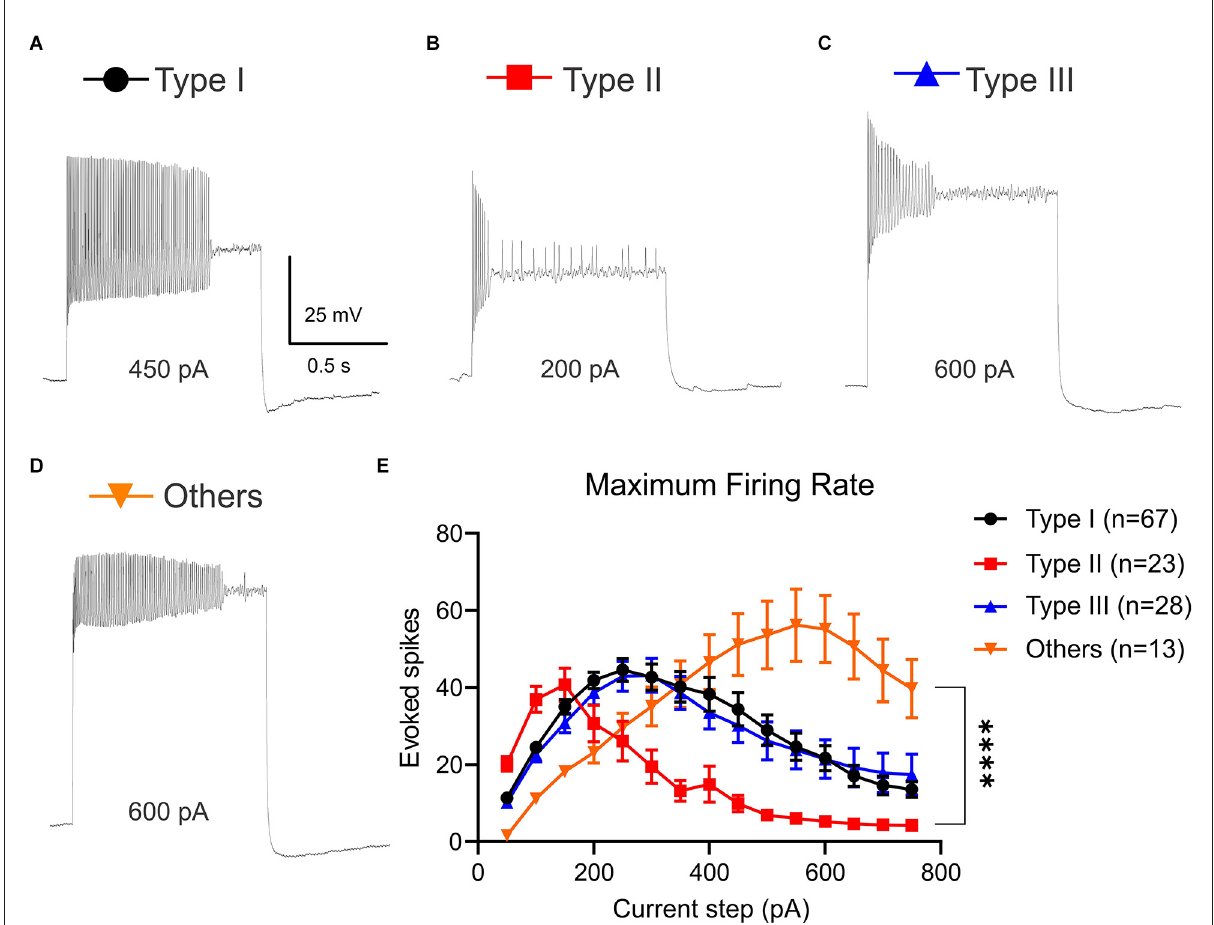
FIGURE3 Maximum firing rate (MFR) of VTA projecting BNST neurons. Current was injected from 50 pA to 750 pA for 1,000 ms. (A–D) Sample traces of each neuron type at current step that exhibits MFR (Type I, 450 pA; Type II, 200 pA, Type III, 600 pA, and Type “Others”, 600 pA). (E) Type II neurons reached depolarization block faster than Type I, Type III, and Type “Others”. A two-way ANOVA revealed that there was a significant interaction between the effect of types and current steps, F (42,1905) = 5.359, P < 0.0001. Tukey post-hoc test revealed that at +500 pA and +550 pA